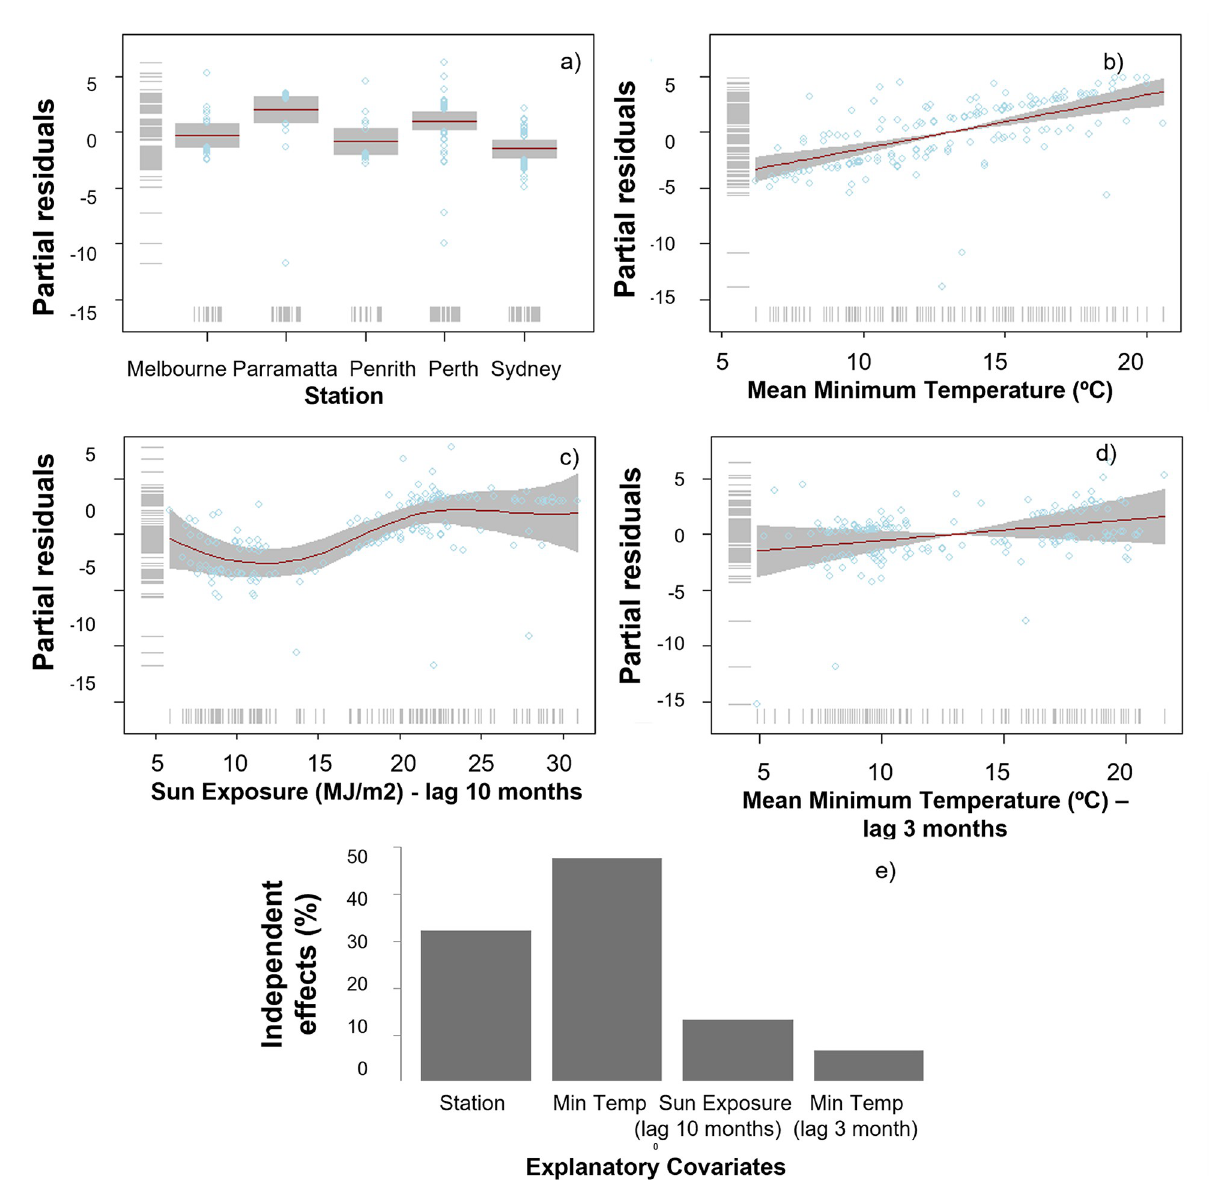
Fig 9. GAMLSS best binomial model explaining the occurrence of Jacaranda flowering between 2009–2019. (a-c) panels showing the partial and the respective percentage contribution of each of the chosen covariates in determining whether or not Jacaranda trees flower (e).